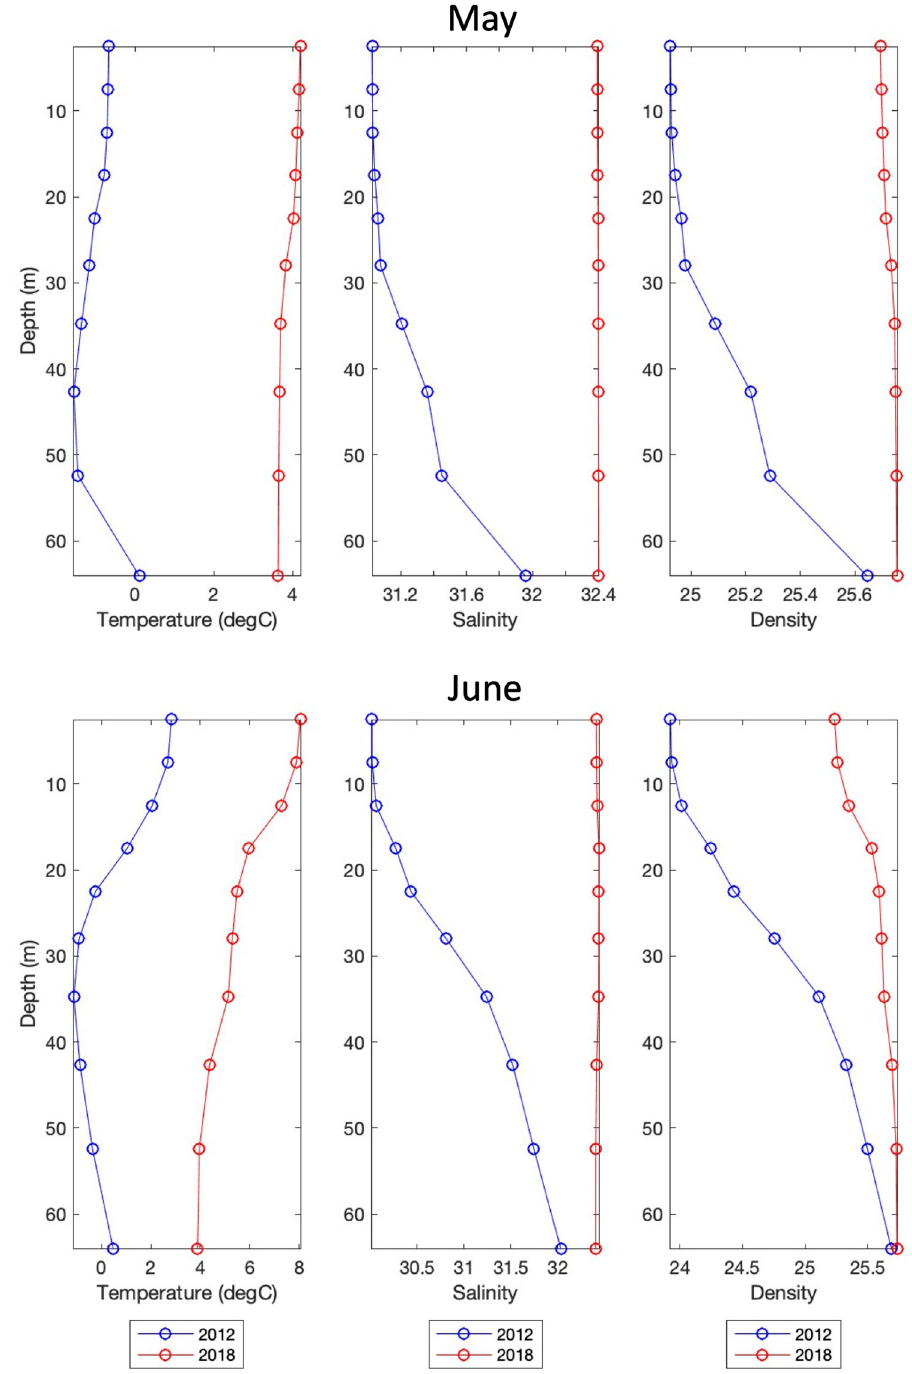
Fig 11. Vertical sections of temperature, salinity, and density. Vertical sections of temperature (˚C), salinity, and density ( σ ) during May (upper) and June (lower) for 2012 (blue) and 2018 (red) from RASM at 60.5˚N, 175˚W (location shown as a small black circle in Fig